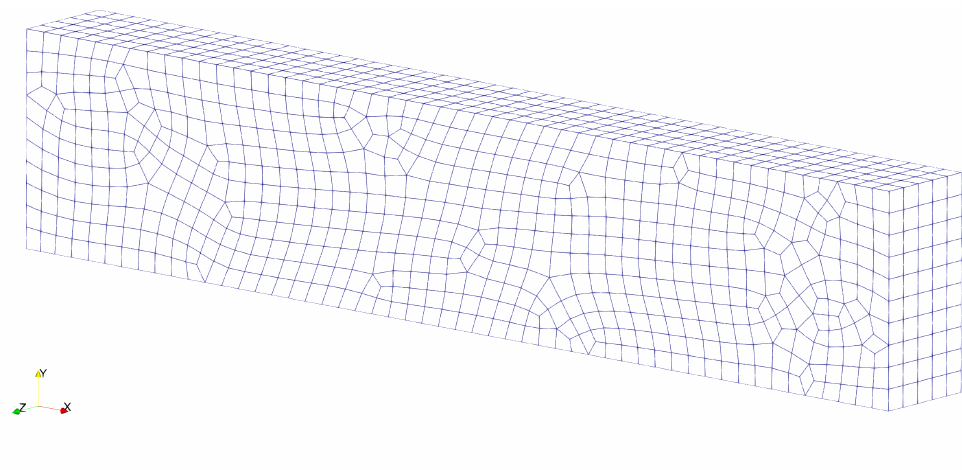
Figure 12. Mesh for Problems